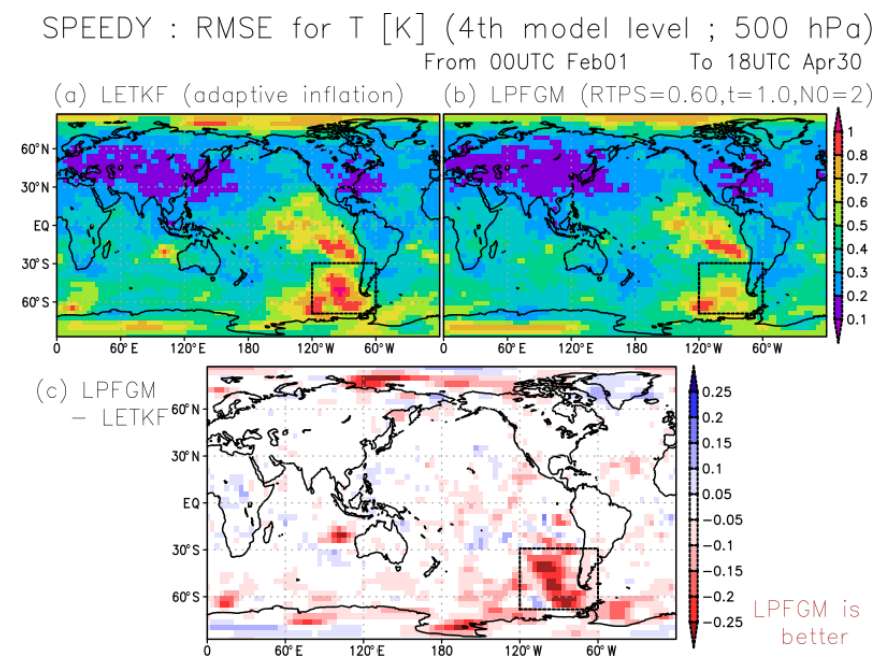
Figure 12. Spatial patterns of background RMSE for T (K) at the fourth model level ( ∼ 500hPa) for (a) LETKF and (b) LPFGM, averaged over February–April, with RAOB and 1100km localization scale. Panel (c) shows the difference between LETKF and LPFGM. Warm (cold) color indicates that the LPFGM is better (worse) than the LETKF. Black dashed rectangles show the region (120–60 ◦ W and 70–30 ◦ S) where the differences between LETKF and LPFGM are investigated in Fig. 14.